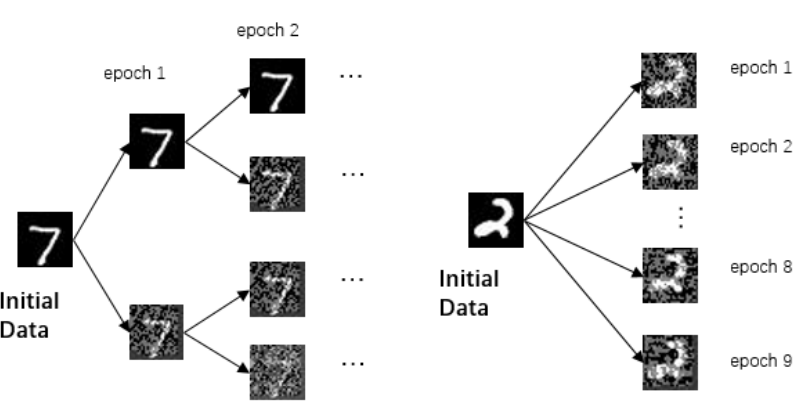
Figure 2. Improvement to Jacobian-based Augmentation. On the left is the original Jacobian-based Augmentation flowchart, and the number of images is increasing exponentially with the epoch growing and the query times will be unacceptable after a few epochs. The right pattern is our improvement that all the augmenting images are from the initial data, and the query times increase linearly